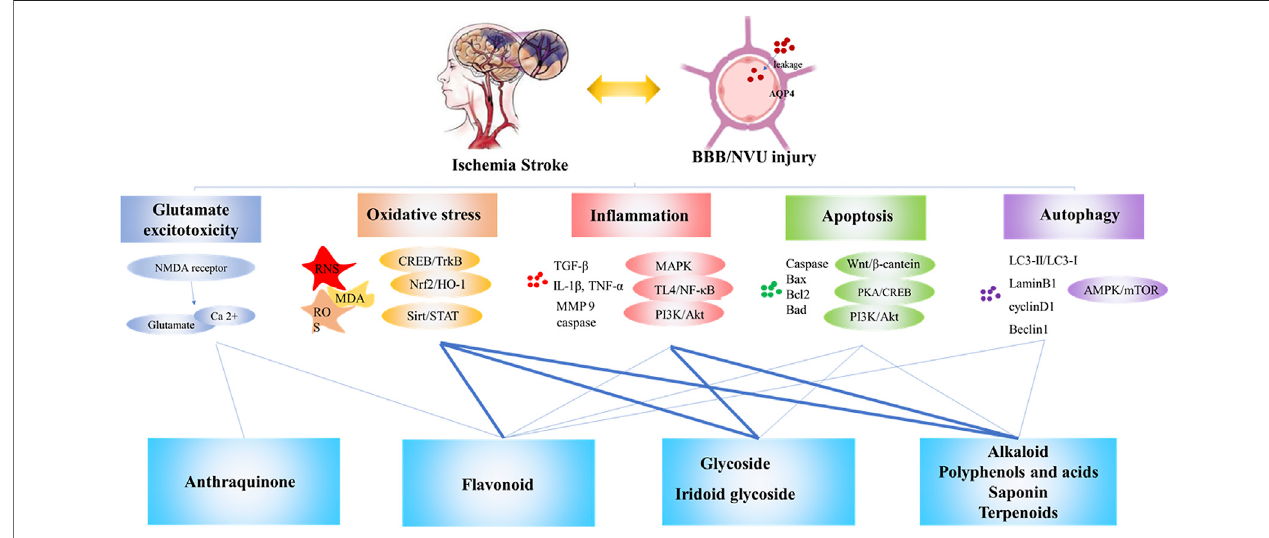
FIGURE 6 | The mechanism of cerebral ischemia and the neuroprotective effect of natural products against cerebral ischemia. Note: Bold lines indicate a clear structure-activity relationship reported in the literature.